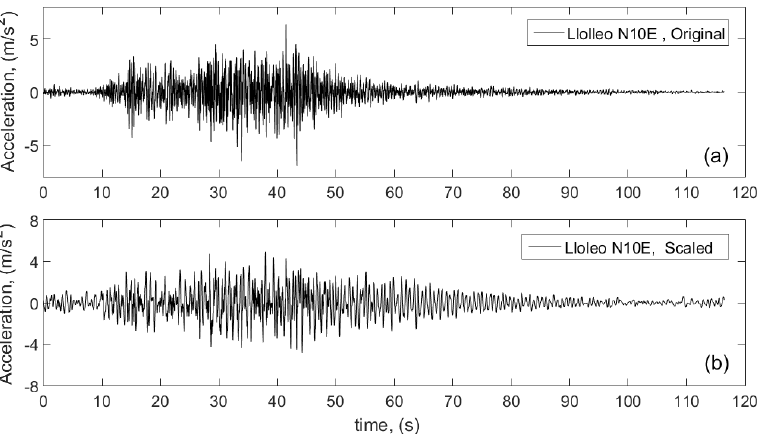
Figure 7. Llolleo seismic record of 3 March 1985, component N10E: ( a ) original record, ( b ) record scaled in frequency domain to fit with design spectrum of